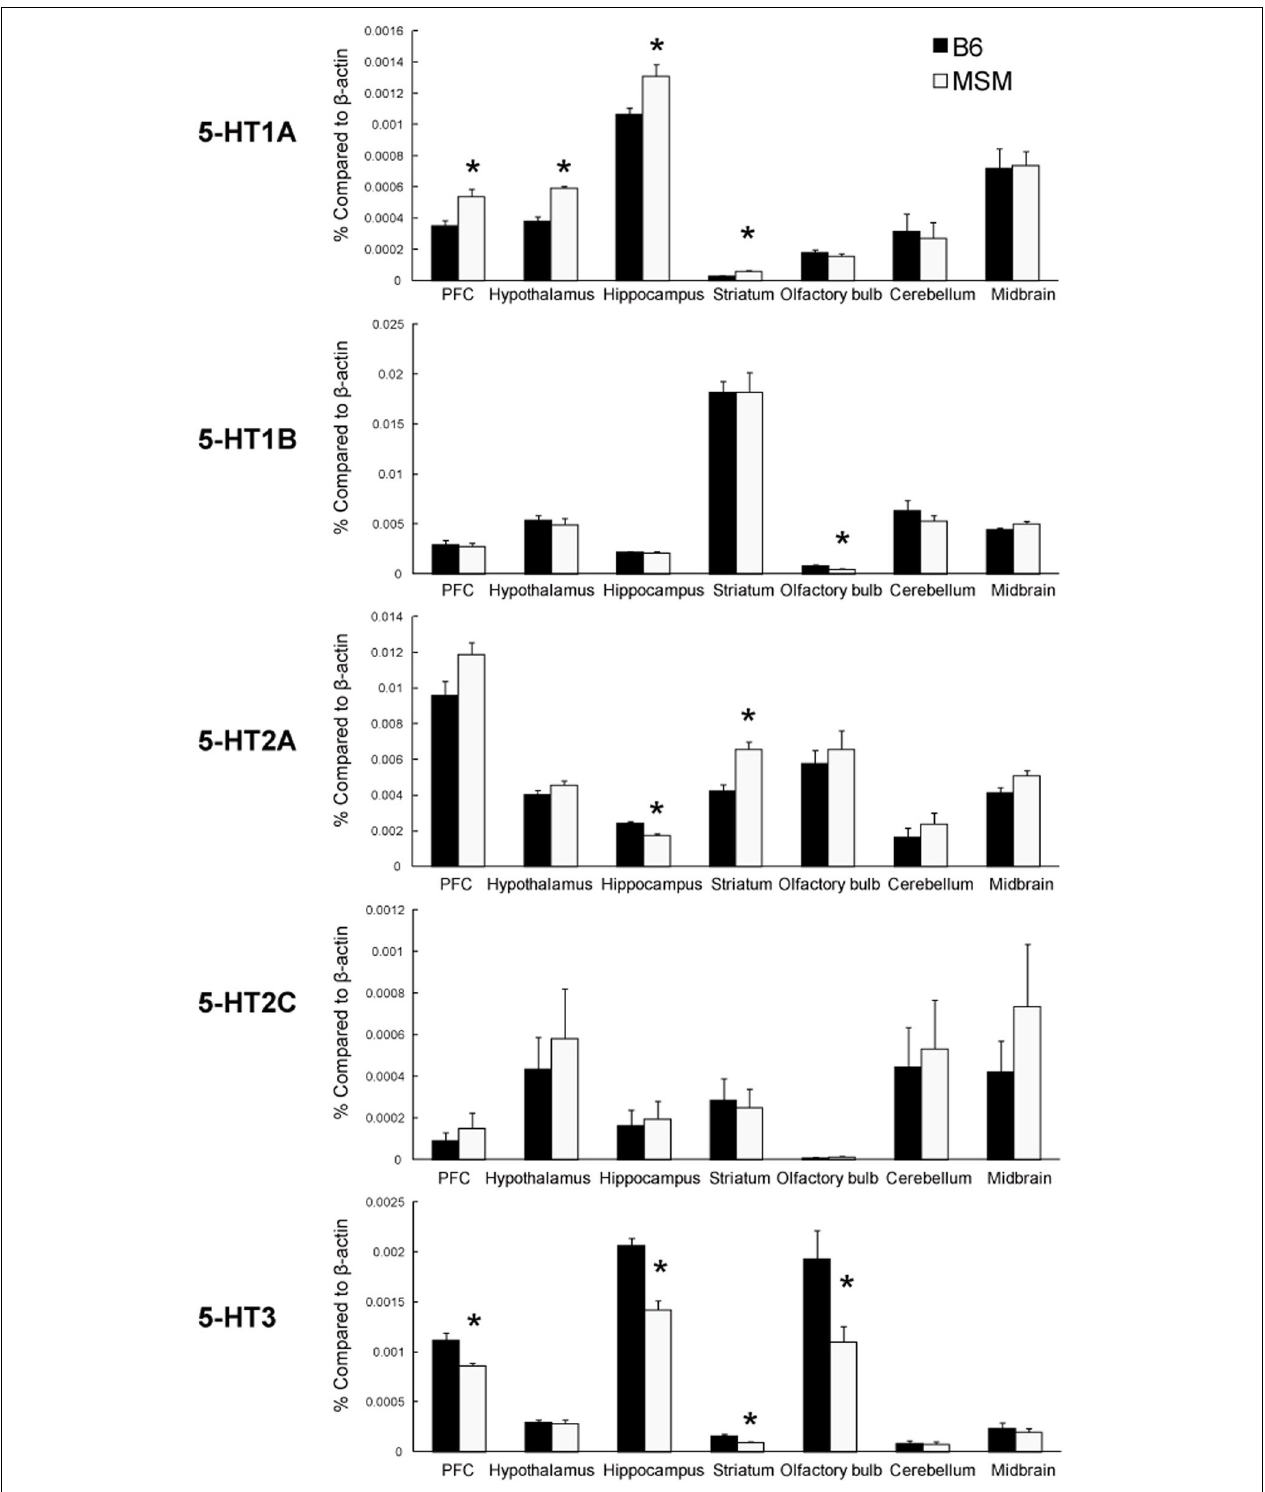
FIGURE 4 | Real-time quantitative PCR analysis of the mRNA expression of 5-HT receptors in seven brain areas of MSM and B6. ∗ Significant strain difference between B6 and MSM ( p < 0 . 05).